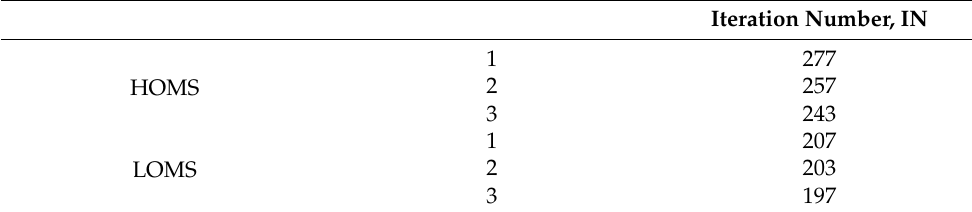
Table 3. Iteration number for each